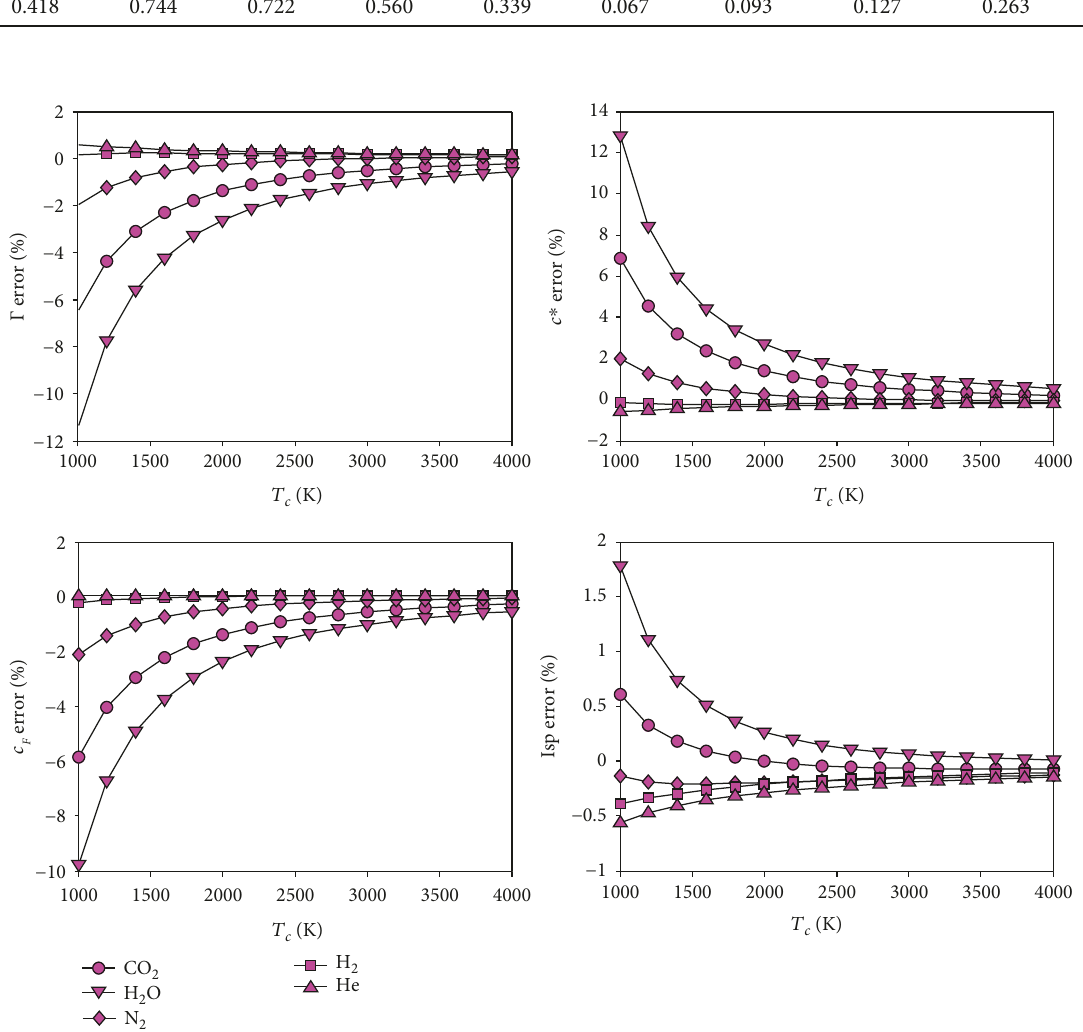
Figure 2: Errors of propulsion parameters of thermally perfect ideal gases with respect to VDW gases at di ff erent chamber temperatures, for / A = 100 and P = 10 vacuum expansion, A e t c